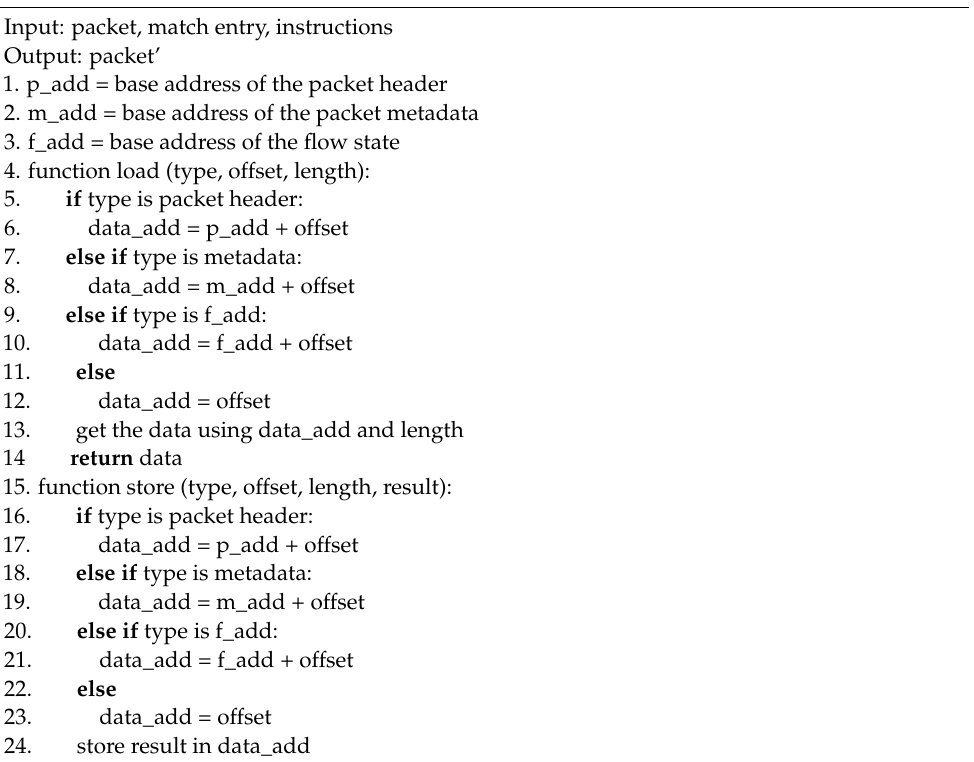
Algorithm 1 . Loading and storing data using {type, offset, length} in